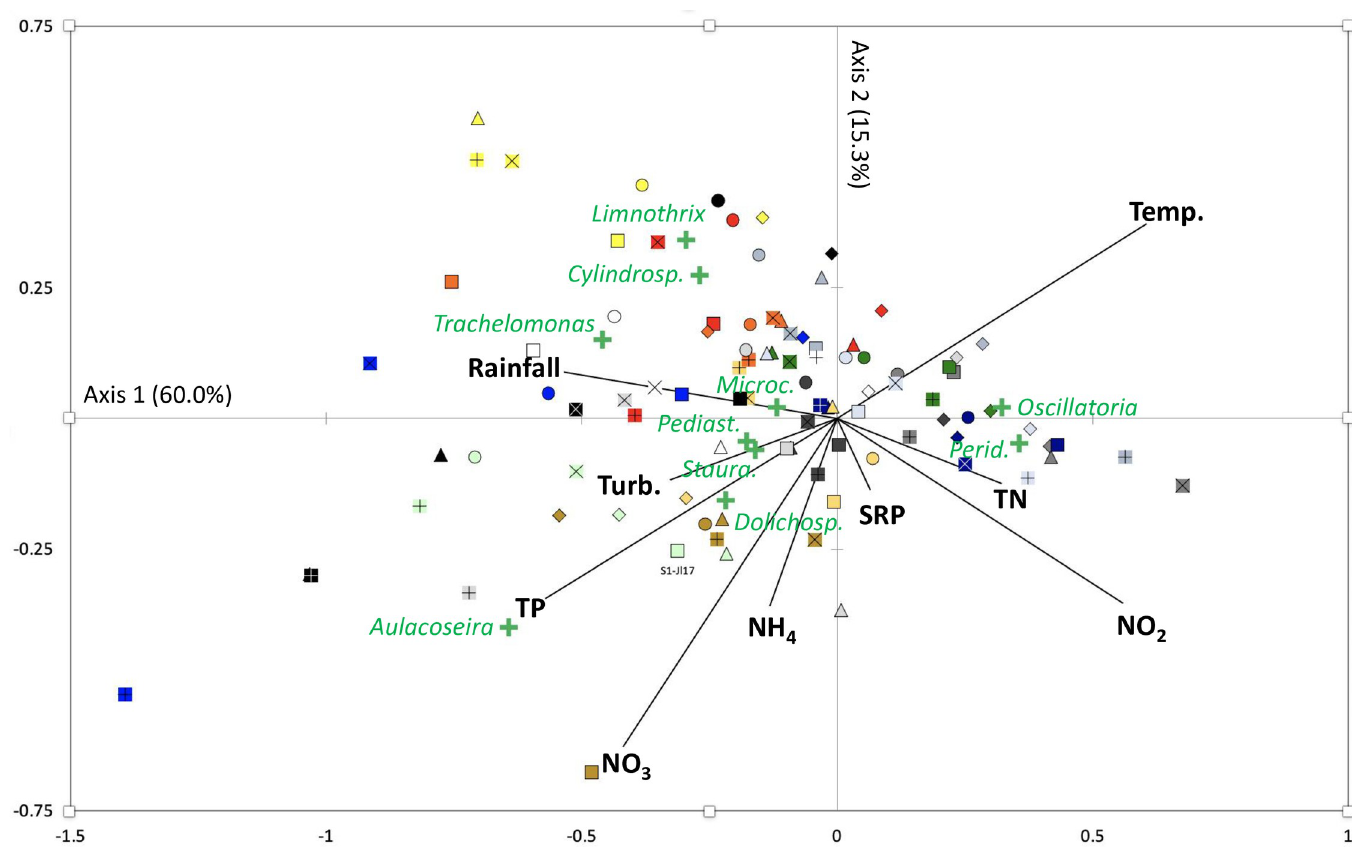
Fig 5. Canonical correspondence analysis was performed on the measured physical and chemical variable values and on the biovolumes of the 10 dominant genera in the phytoplankton community during the monitoring of Lagoon Aghien from January 2017 to April 2018. Cylindrosp. = Cylindrospermopsis ; Microc. = Microcystis ; Pediast. = Pediastrum ; Staura. = Staurastrum ; Dolichosp. = Dolichospermum ; and Perid. = Peridinium . SRP = soluble reactive phosphorus; TN = total nitrogen; TP = total phosphorus; NH 4 = ammonium; NO 2 = nitrite; NO 3 = nitrate; Turb. = turbidity; Temp. = water temperature. Significance of the symbols: Square symbol = station 1; circle = station 2; diamond = station 3; triangle = station 4; “x” = Station 5; “+” = station 6. Colors of the symbols: Jan 2017 = blue gray; Feb 17 = gray 2; Mar 17 = dark blue; Apr 17 = green; May 17 = gold; Jun 17 = blue; Jul 17 = light green; Aug 17 = brown; Sep 17 = white; Oct 17 = black; Nov 17 = red; Dec 17 = orange; Jan 18 = light blue; Feb 18 = gray 3; Mar 18 = yellow; Apr 18 = gray